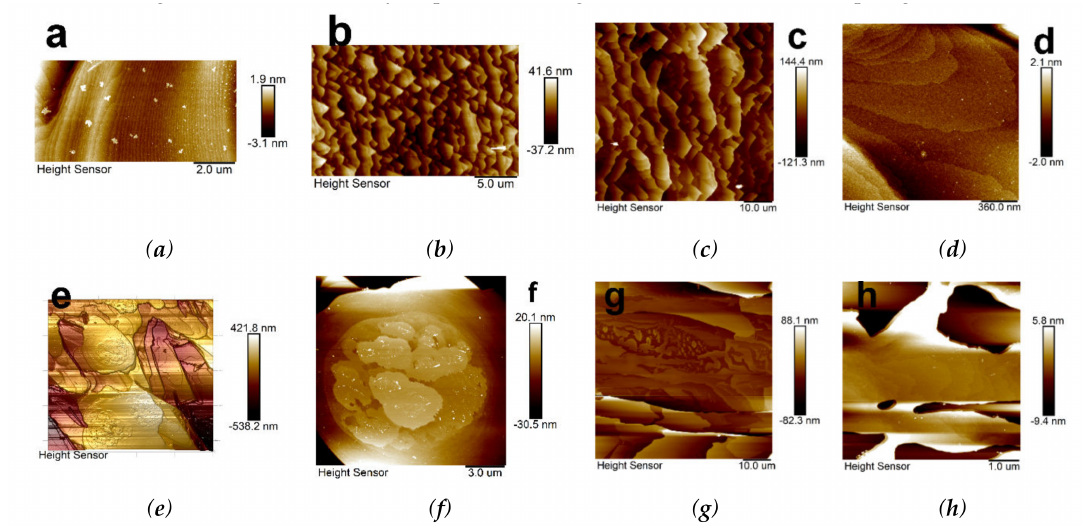
Figure 1. Microtopography of (100) faces of KDP crystals grown in [101] direction under di ff erent supersaturation: ( a ) σ = 0.38%; ( b ) σ = 0.74%; ( c ), ( d ) σ = 3.94%; ( e ), ( f ) σ = 5.99%; ( g ), ( h ) σ = 8.09%.